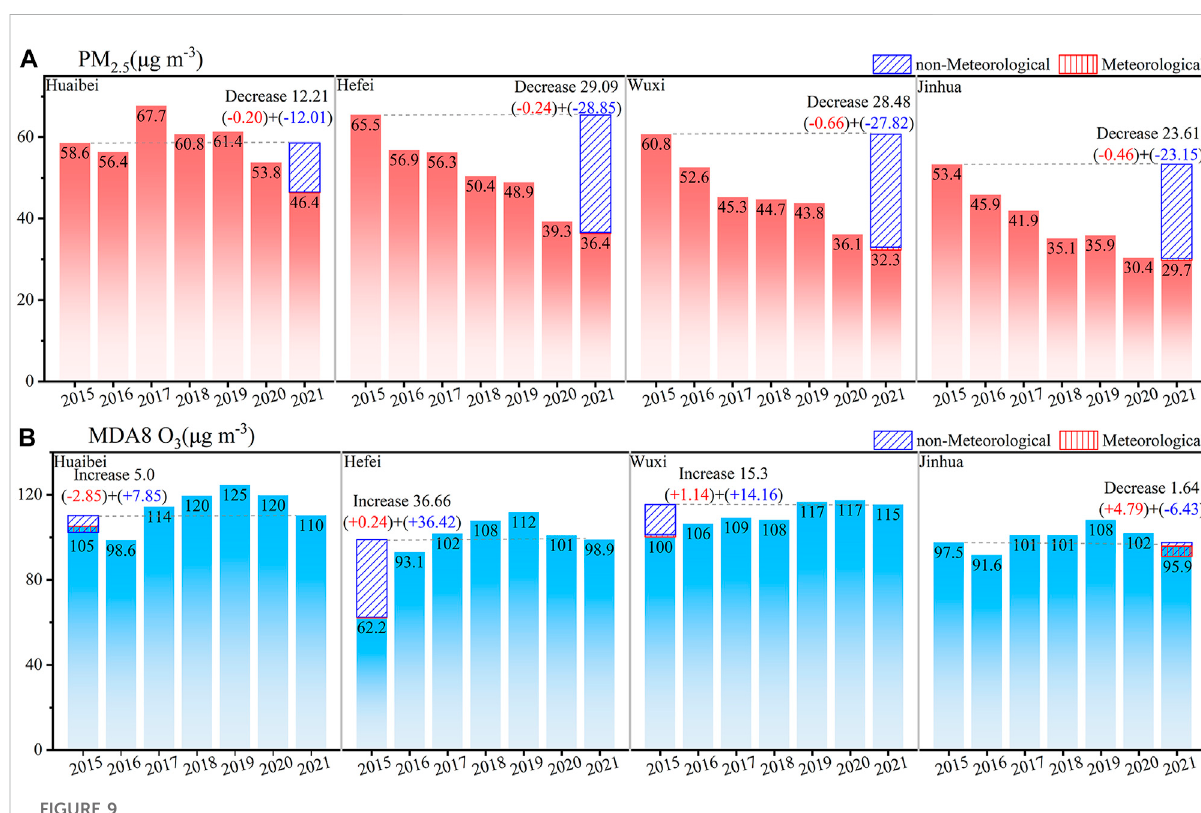
FIGURE 9 Contributions of meteorological-driven and non-meteorological factors to (A) PM 2.5 and (B) MDA8 O 3 changes between 2015 and 2021 in Huaibei,Hefei,Wuxi,andJinhua.ObservedannualPM 2.5 andMDA8O 3 from2015through2021areshowninsolidbarsandblacknumbers.Theblack values represent the increase or decrease in observed PM 2.5 and MDA8 O 3 between 2015 and 2021. The red bars and values represent meteorological-driven changes in PM 2.5 or MDA8 O 3 between 2015 and 2021, while those in blue represent non-meteorology